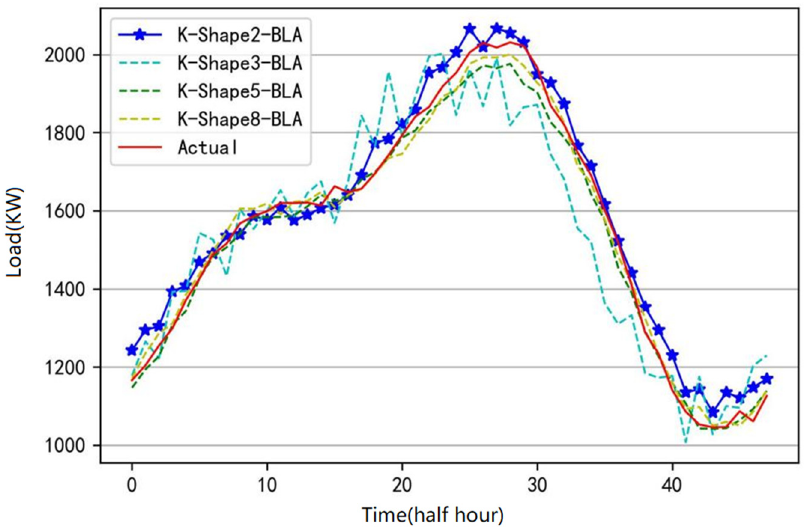
Figure 8. Graph of daily load forecast results.